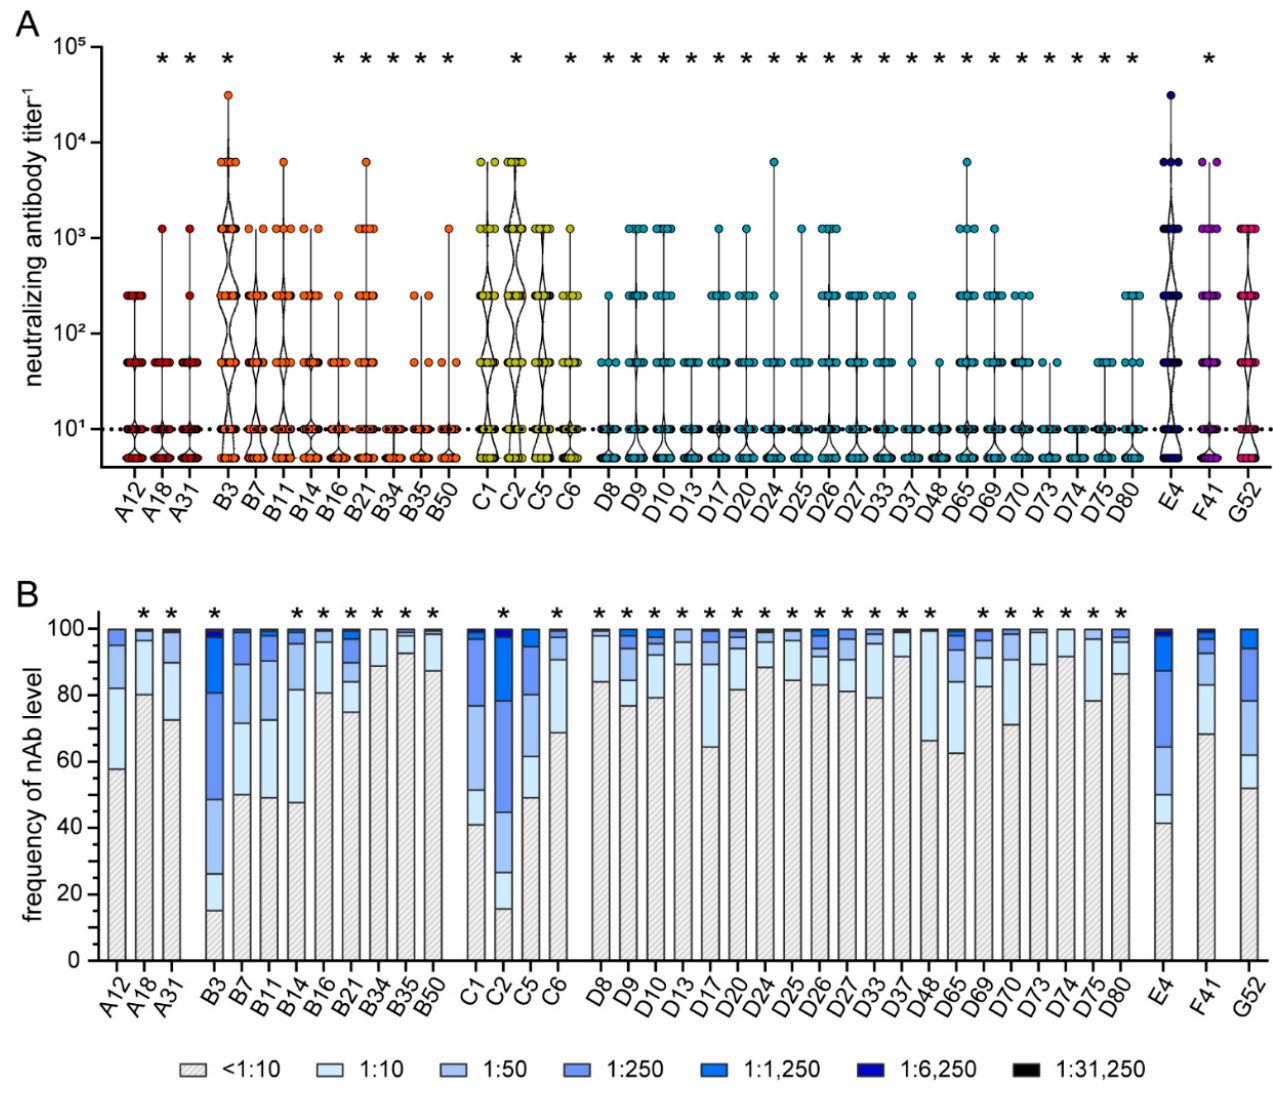
Figure 6. Neutralizing antibody levels and prevalence. Neutralizing antibodies were analyzed using 209 samples of healthy volunteers and volunteers with NMD. Serum samples were serially diluted and tested for their reactivity against the 39 indicated HAdV types. The highest serum dilutions that resulted in neutralization of 90% of input virus for each serum sample for the indicated HAdV types are shown in ( A ). The percentage of serum samples with the indicated neutralizing antibody levels against the indicated HAdV types are shown in ( B ). Each dot represents an individual sample. Significant differences in neutralizing antibody levels ( A ) compared to HAdV-C5 are indicated by * ( p < 0.05, Kruskal-Wallis one-way ANOVA on ranks, Dunn´s multiple comparisons test). Significant differences in neutralizing antibody prevalence ( B ) compared to HAdV-C5 are indicated by * ( p < 0.05, Chi square test with Bonferroni adjustment for multiple comparisons).